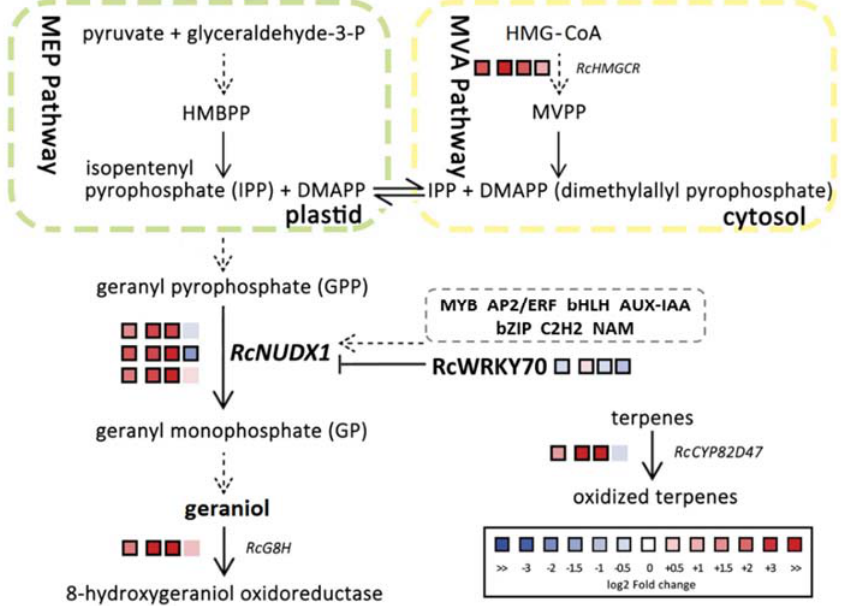
Figure 6. Proposed model of transcriptional regulation of the geraniol metabolic pathway in R. chinensis . Each row of the heatmap from left to right represents Log2 (Fold-change) in different developmental stages (FB_CP vs. FB_GP, FB_PP vs. FB_CP, and OF_PP vs. FB_PP) and different samples (OB vs. OBL). The color of each box indicates downregulation (blue) or upregulation (red). Bold margins identify significant differences ( p ≤ 0.05) between treatments. MVPP, mevalonate-5- pyrophosphate; HMBPP, ( E )-4-hydroxy-3-methyl-but-2-enyl pyrophosphate; HMG–CoA, 3-hydroxy- 3-methylglutaryl-CoA; NUDX, nudix hydrolase; TPS, terpene synthase; G8H, geraniol 8-hydroxylase. Transcript levels for each gene are reported in Table